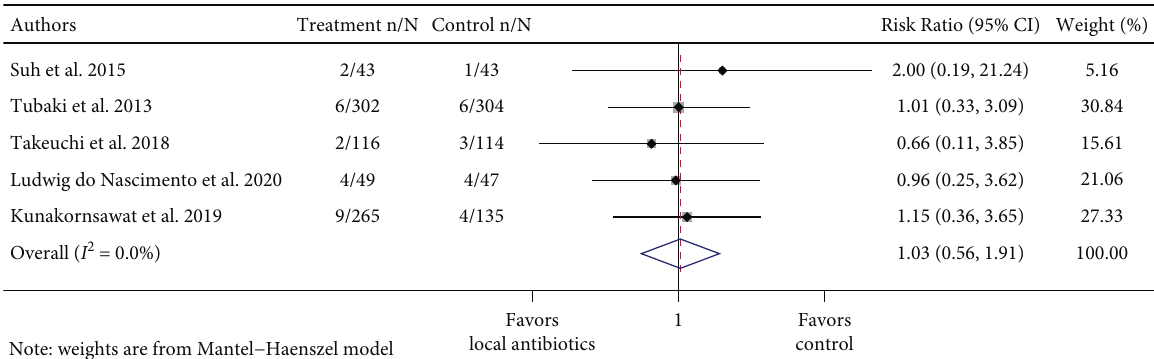
Figure 2: Forest plot of infection data of 5 instrumented spinal fusion randomized controlled trials. Treatment n/N: number of infections in the treatment group/total number of patients in the treatment group. Control n/N: number of infections in the control group/total number of patients in the control